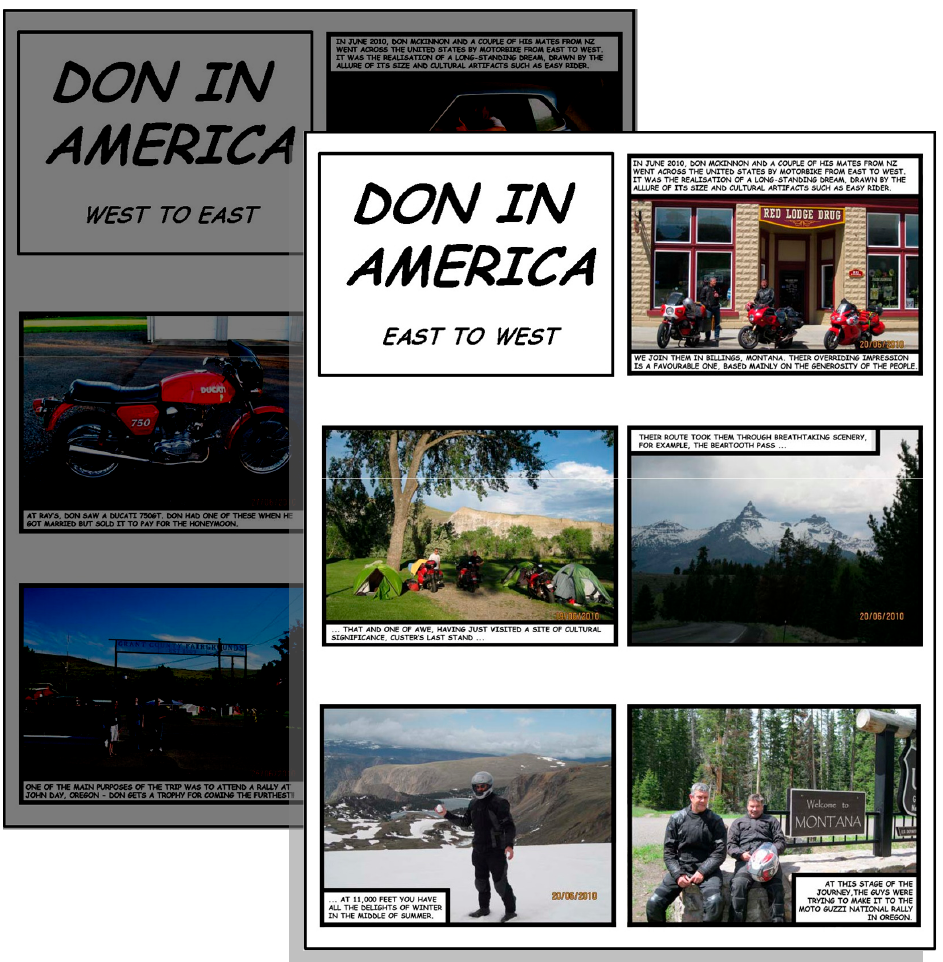
Figure 5. First page of a photo strip based on holiday photographs, arranged as a two way narrative (enabled by 3D viewing in the space-time environment).